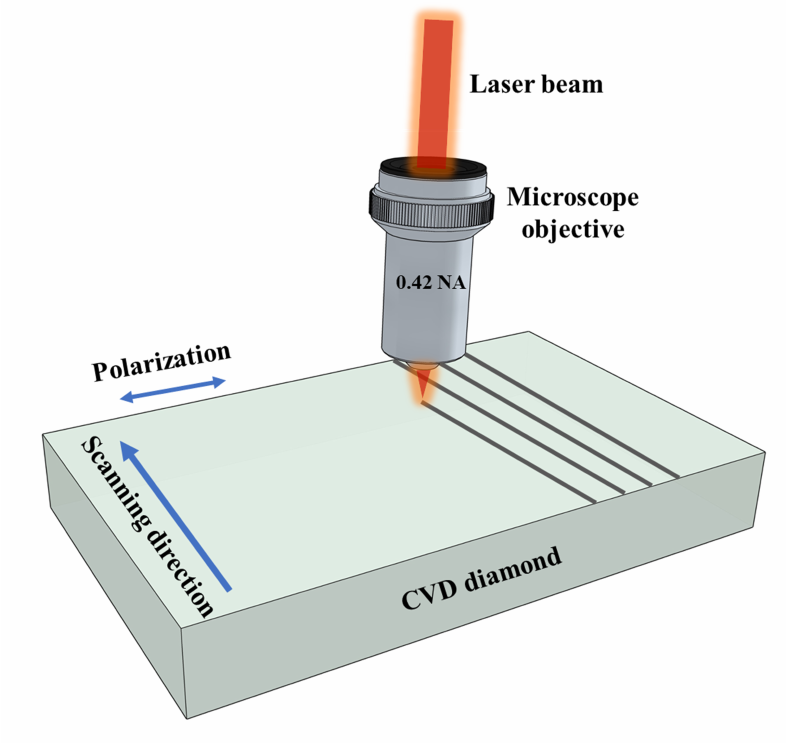
Figure 1. Schematic layout of the femtosecond laser writing